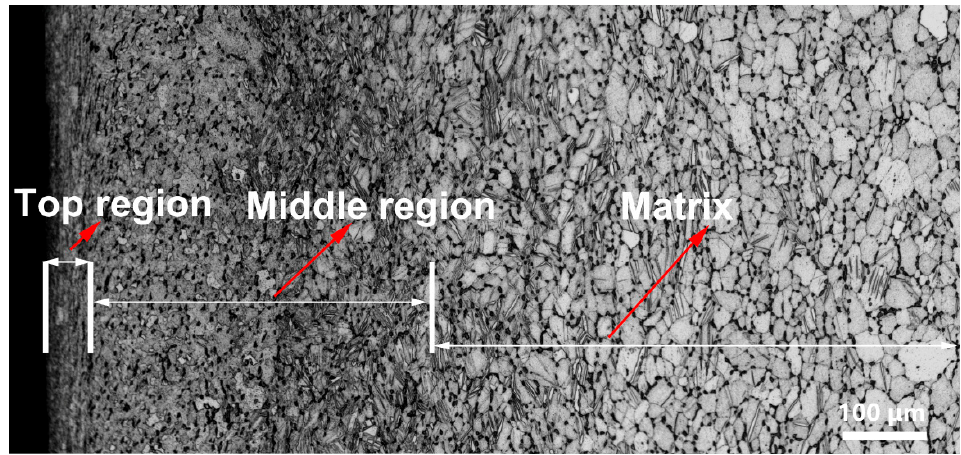
Figure 1. Optical micrograph (OM) image of the cross sectional in the sliding-friction treatment (SFT)-treated Zn alloy.